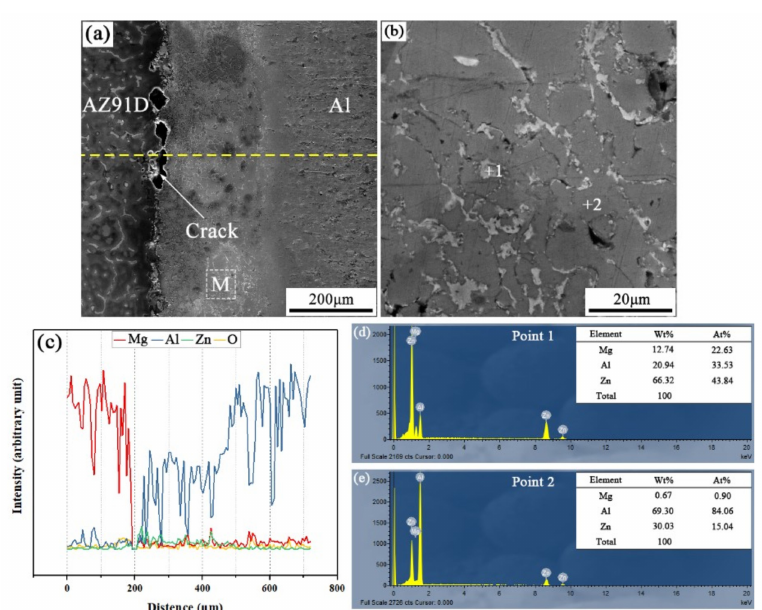
Figure 4. Arc-sprayed Al / AZ91D bimetals with a Zn interlayer (arc-spraying Zn for 10 s and Al / Zn double-deck coating preheated for 12 h): ( a ) SEM micrograph of interface, ( b ) SEM micrograph of area M in ( a ), ( c ) EDS line scan spectrum (marked as dashed line in ( a )), ( d , e ) EDS point scan spectra of points 1 and 2 in ( b